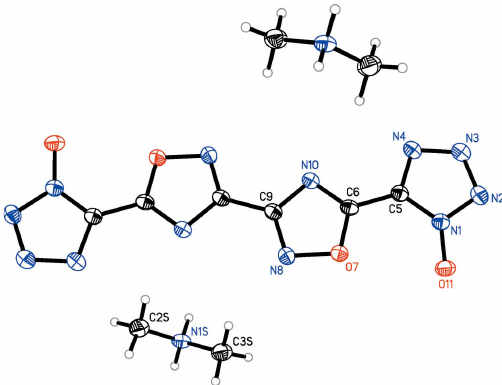
Figure 3 Molecular structure of 3 , showing the atom-labeling scheme. Displace- ment ellipsoids are drawn at the 50% probability level.